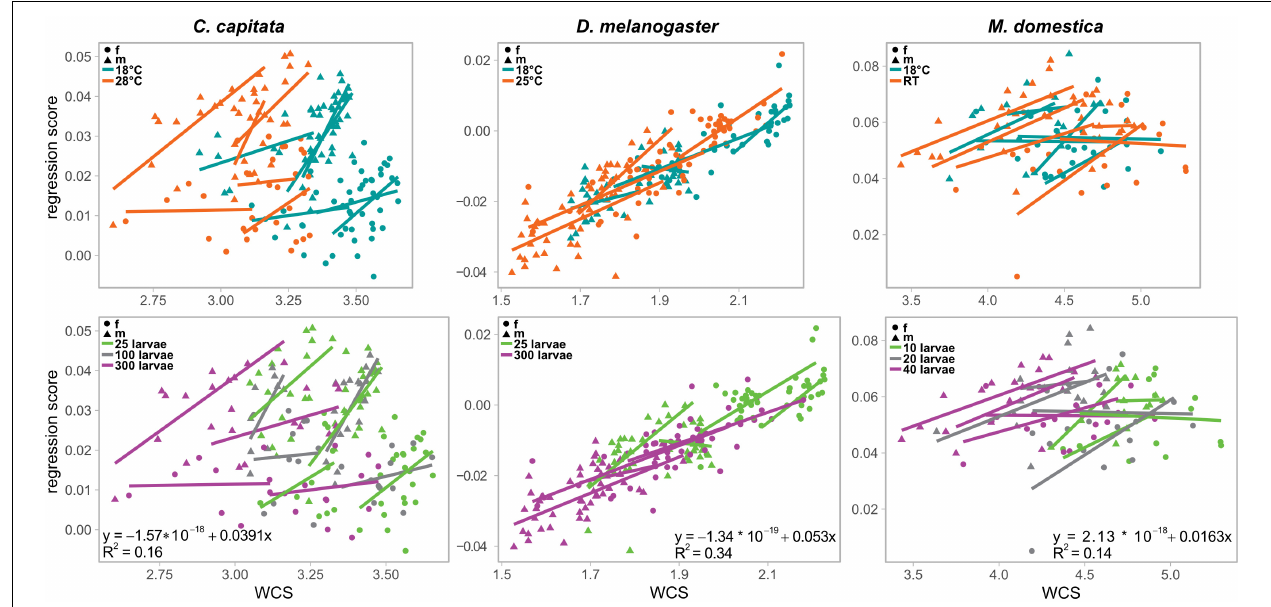
FIGURE 3 | Relationship of the shape component that is most associated with wing size and wing centroid size. Scatterplots showing the relationship of the regression score (i.e., regression of wing centroid size onto Procrustes coordinates pooled by sex, temperature, and density) and wing centroid size (WCS). Linear regression lines were fitted for each category to illustrate the allometric relationships in detail. In the upper row, the data is color coded by the different rearing temperatures and in the lower row, the data is color coded by the different rearing temperatures. Equations and corresponding R 2 values in the plots of the lower row represent pooled regressions for all data combined for each species. f, females; m,